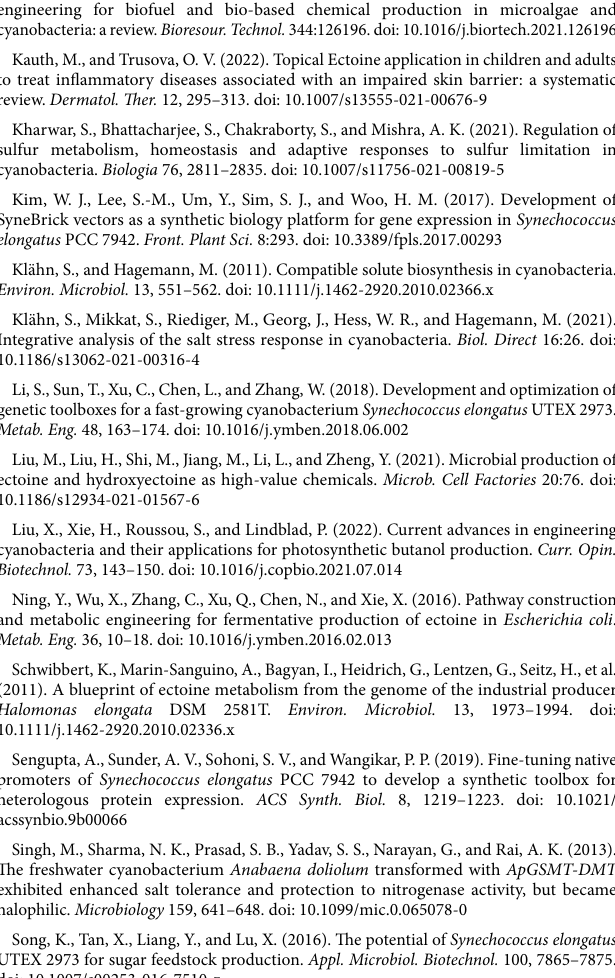
SUPPLEMENTARY FIGURE S3 The number of DEGs in WTand Syn7942/ Δ sps-ect. (A) The number of up- regulated genes; (B) The number of down-regulated genes. WT: 300 mM VS 0 mM NaCl indicates the DEGs of WT under 300 mM NaCl compared with 0 mM NaCl condition; Syn7942/ Δ sps-ect: 300 mM VS 0 mM NaCl indicates the DEGs of Syn7942/ Δ sps-ect under 300 mM NaCl compared with 0 mM NaCl condition; 0 mM NaCl: Syn7942/ Δ sps-ect VS WT indicates the DEGs of Syn7942/ Δ sps-ect grown in 0 mM NaCl condition compared to WT; 300 mM NaCl: Syn7942/ Δ sps-ect VS WT indicates the DEGs of Syn7942/ Δ sps-ect grown in 300 mM NaCl condition compared to